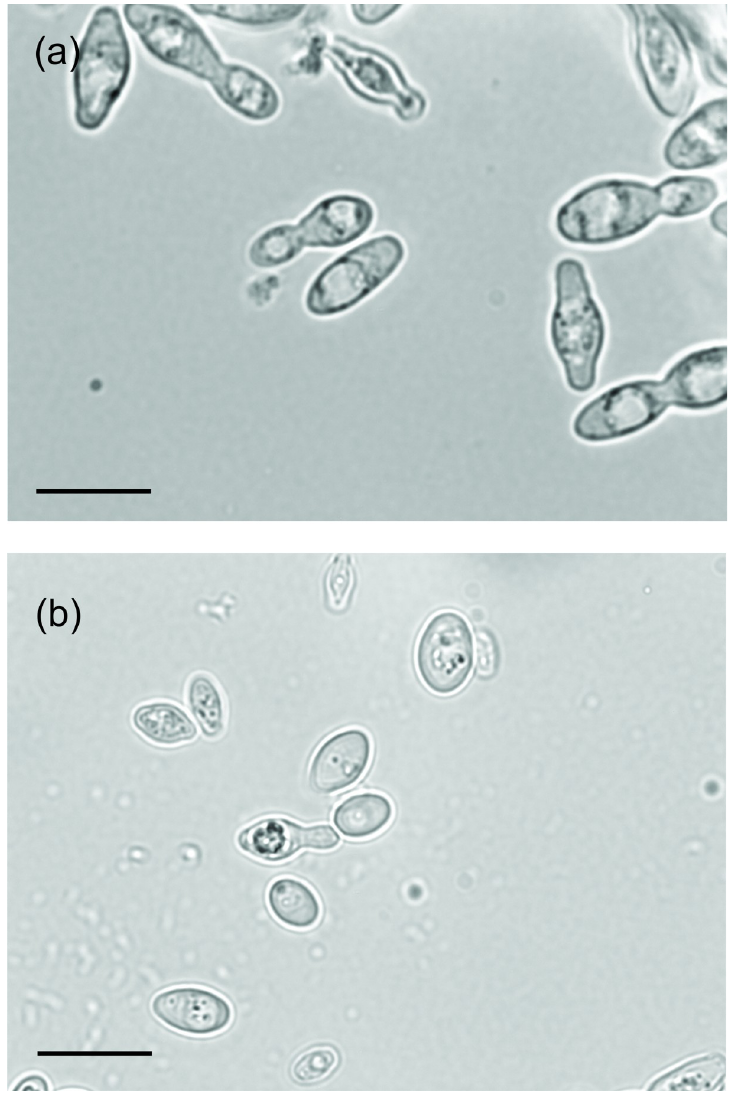
Fig 5. Hanseniapora gamundiae sp. nov. CRUB 1928 T . (a) Budding cells, YM broth, 25˚C, 220 rpm, 2 days. (b) Sphaerical and warty ascospore, 5% malt extract agar after 21 days at 25˚C. Scale bars, 10 μ